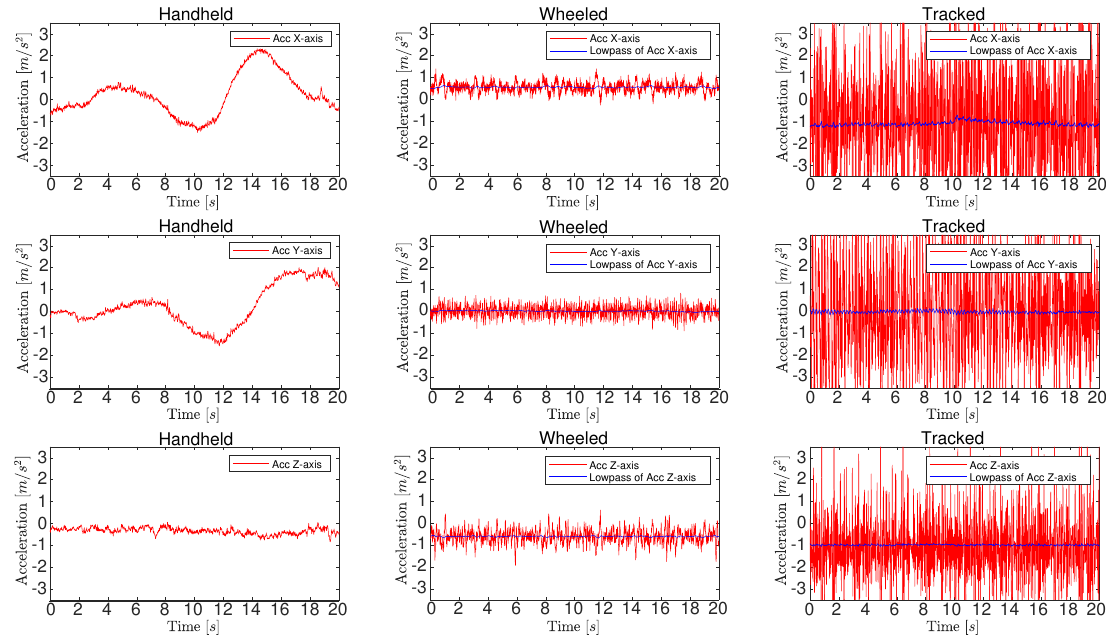
Figure 2. Acceleration values of handheld, wheeled robots and tracked robots shown separately. The left column is three-axis acceleration under normal handheld motion, the middle column is the acceleration of a wheeled robot which is driving a circular motion. The right column is the acceleration of a tracked robot which is under a uniform, linear motion. The red curves indicate measured raw acceleration values of the IMU sensors and the blue curves in the two right columns indicate the acceleration values after a lowpass